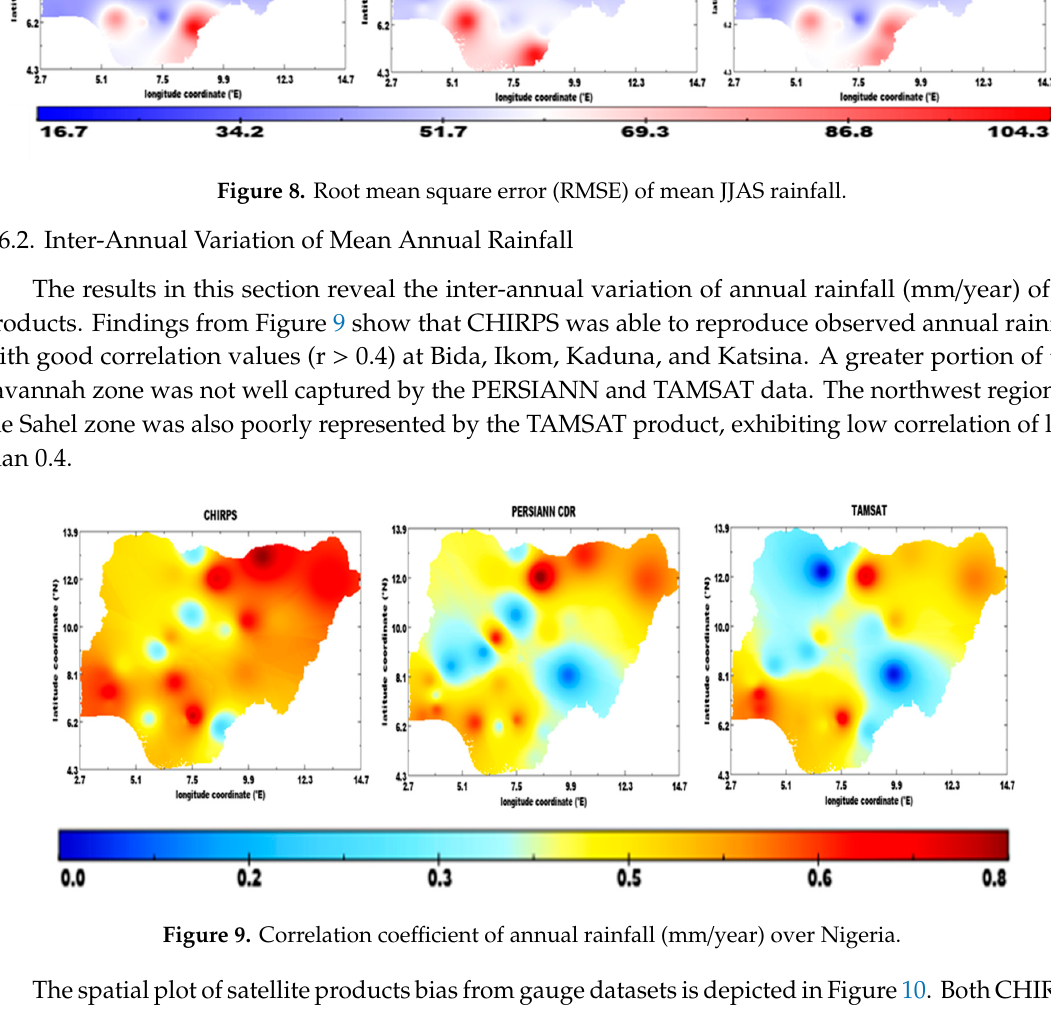
Figure 7. Percent bias (PBIAS) of mean JJAS rainfall.